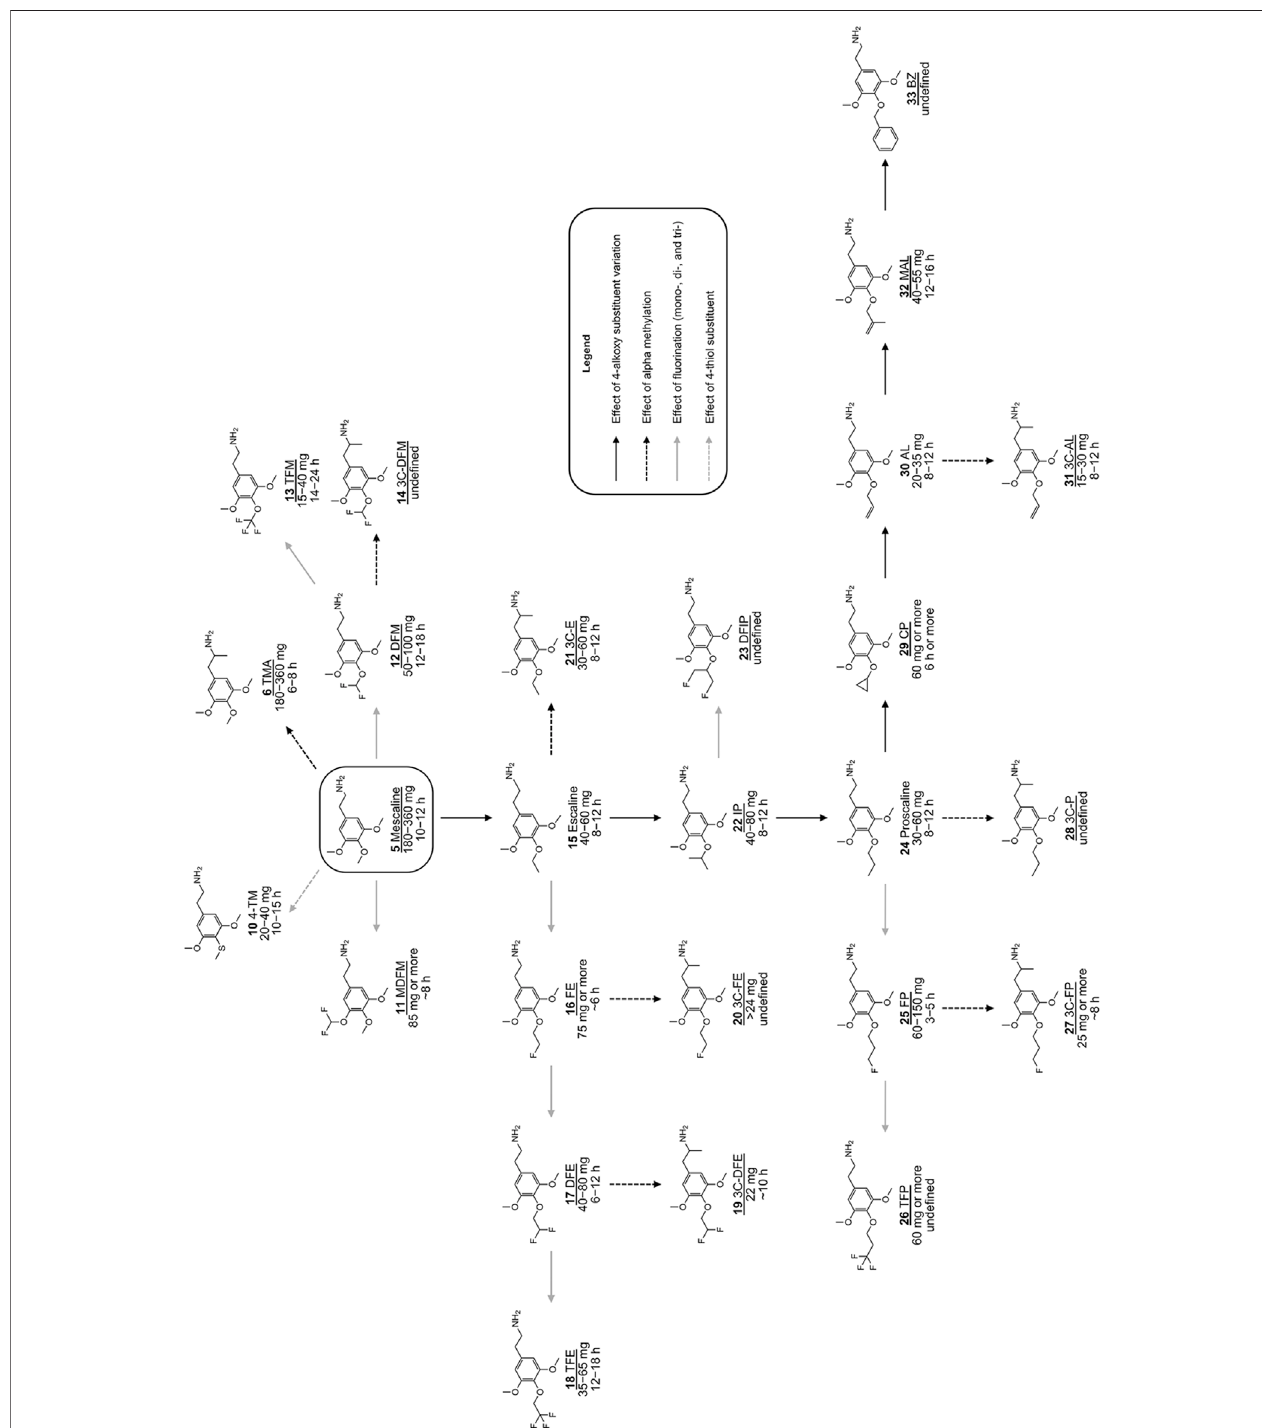
FIGURE2| Chemicalstructuresofvariouspreviouslyinvestigatedscalinesand3C-scalines(ShulginandShulgin1991;ShulginandShulgin1997;Trachseletal.,2013). Human oral doses and duration of action were taken from (Shulgin and Shulgin 1991; Shulgin and Shulgin 1997; Trachsel et al., 2013). Compounds tested in vitro in the present investigation are